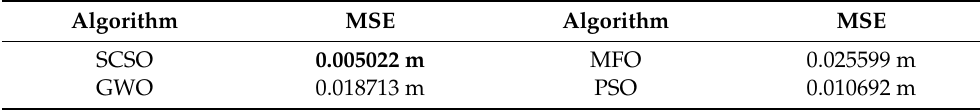
Table 4. The overall performance of each algorithm in the cultivation